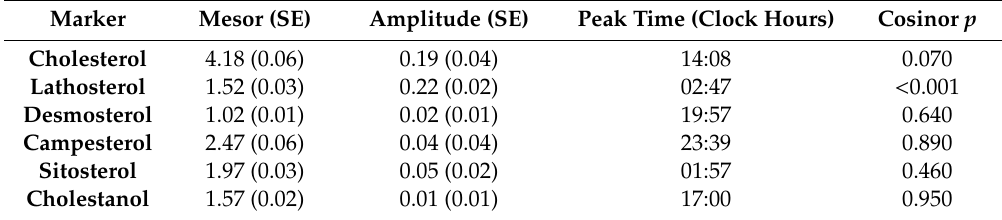
Table 3. Results of the cosinor analysis for total cholesterol, and markers reflecting endogenous cholesterol synthesis and intestinal cholesterol absorption in healthy males ( n =